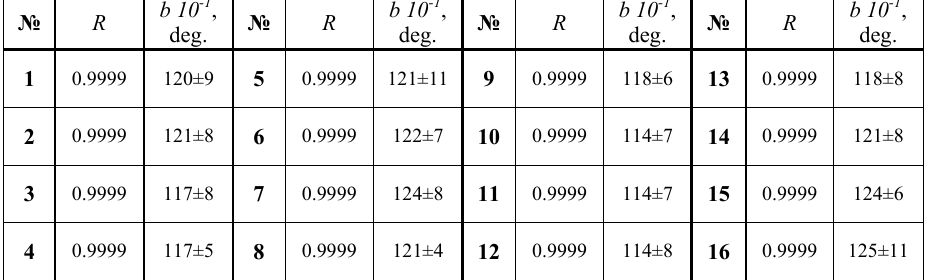
Table 2. The values of the coefficients of linear correlation and linear